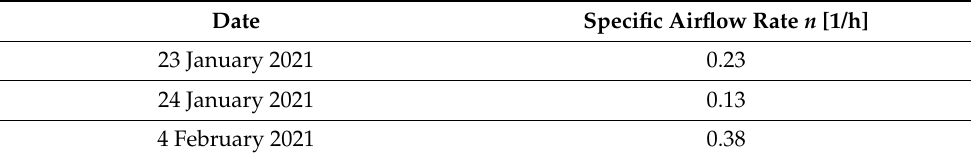
Table 4. Specific airflow rate calculations for different days.